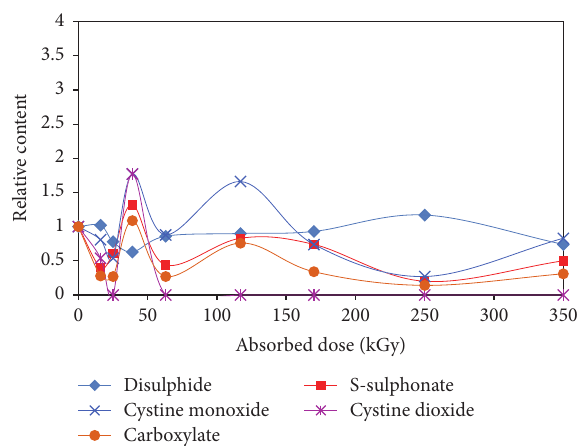
Figure 4: Development of relative content of disulphides, S-sul- fonate, cysteine monoxide, cysteine dioxide, and carboxylates in the wool with absorbed dose 123 days after electron beam irradiation.